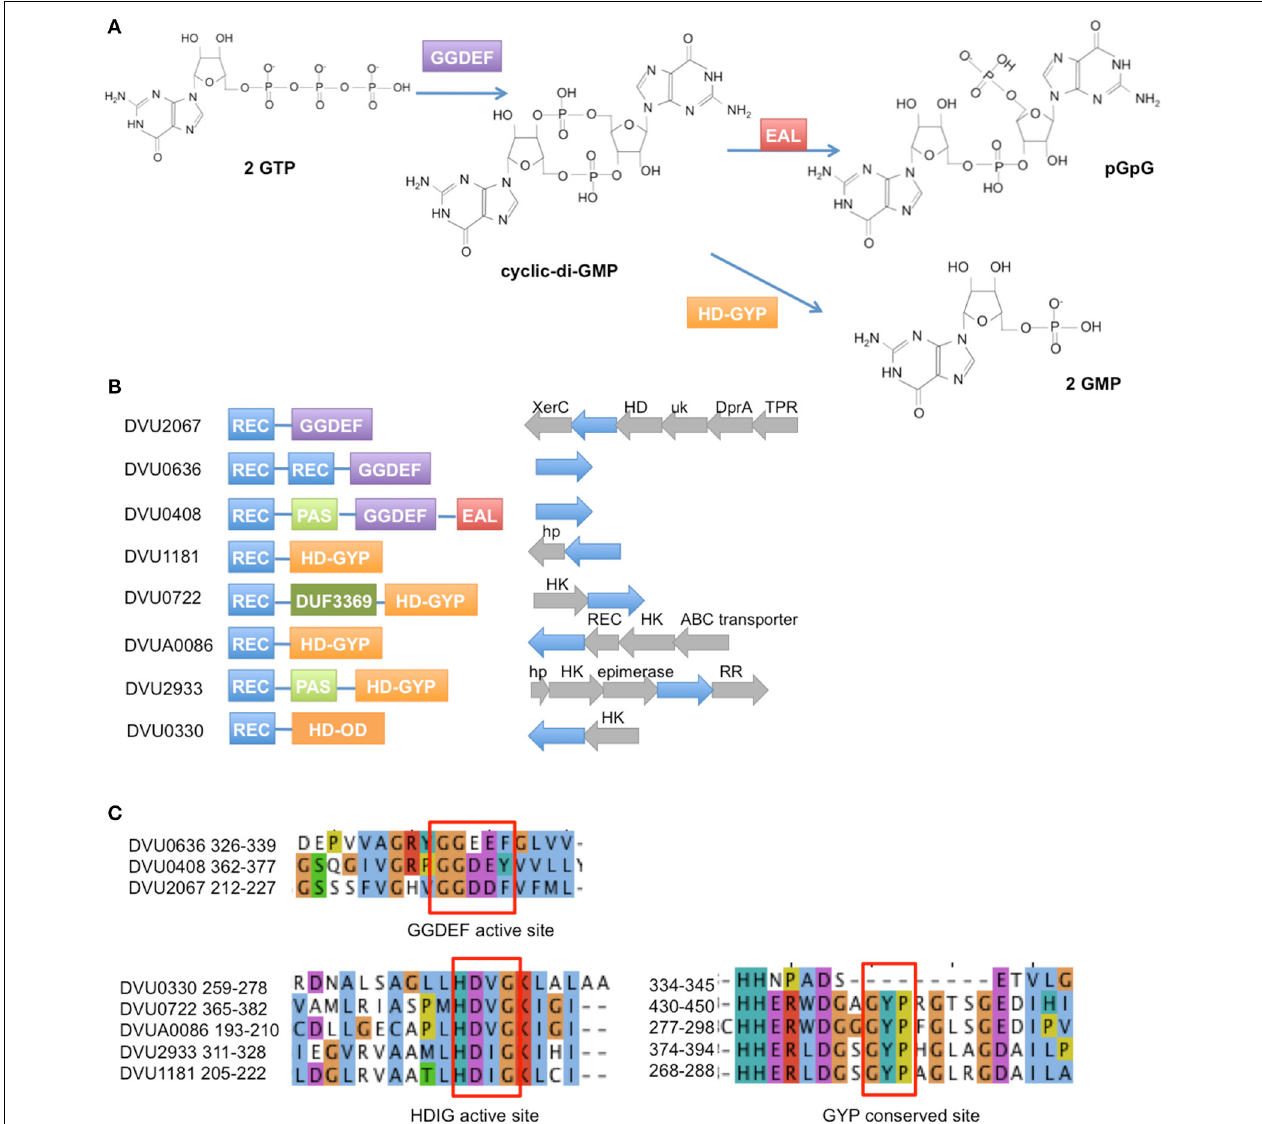
FIGURE 1 | Response regulators in D. vulgaris Hildenborough with GGDEF, EAL, and HD domains. (A) The GGDEF domain synthesizes c-di-GMP from GTP, while the EAL and HD-GYP domains hydrolyze c-di-GMP to pGpG and GMP, respectively. (B) Domain structures are shown for the 2 GGDEF domain RRs, 1 GGDEF-EAL RR, 4 HD-GYP RRs, and 1 HDOD RR (REC = receiver domain). To the right of the domain structures are shown the operon arrangements of each RR with the RR gene shown in